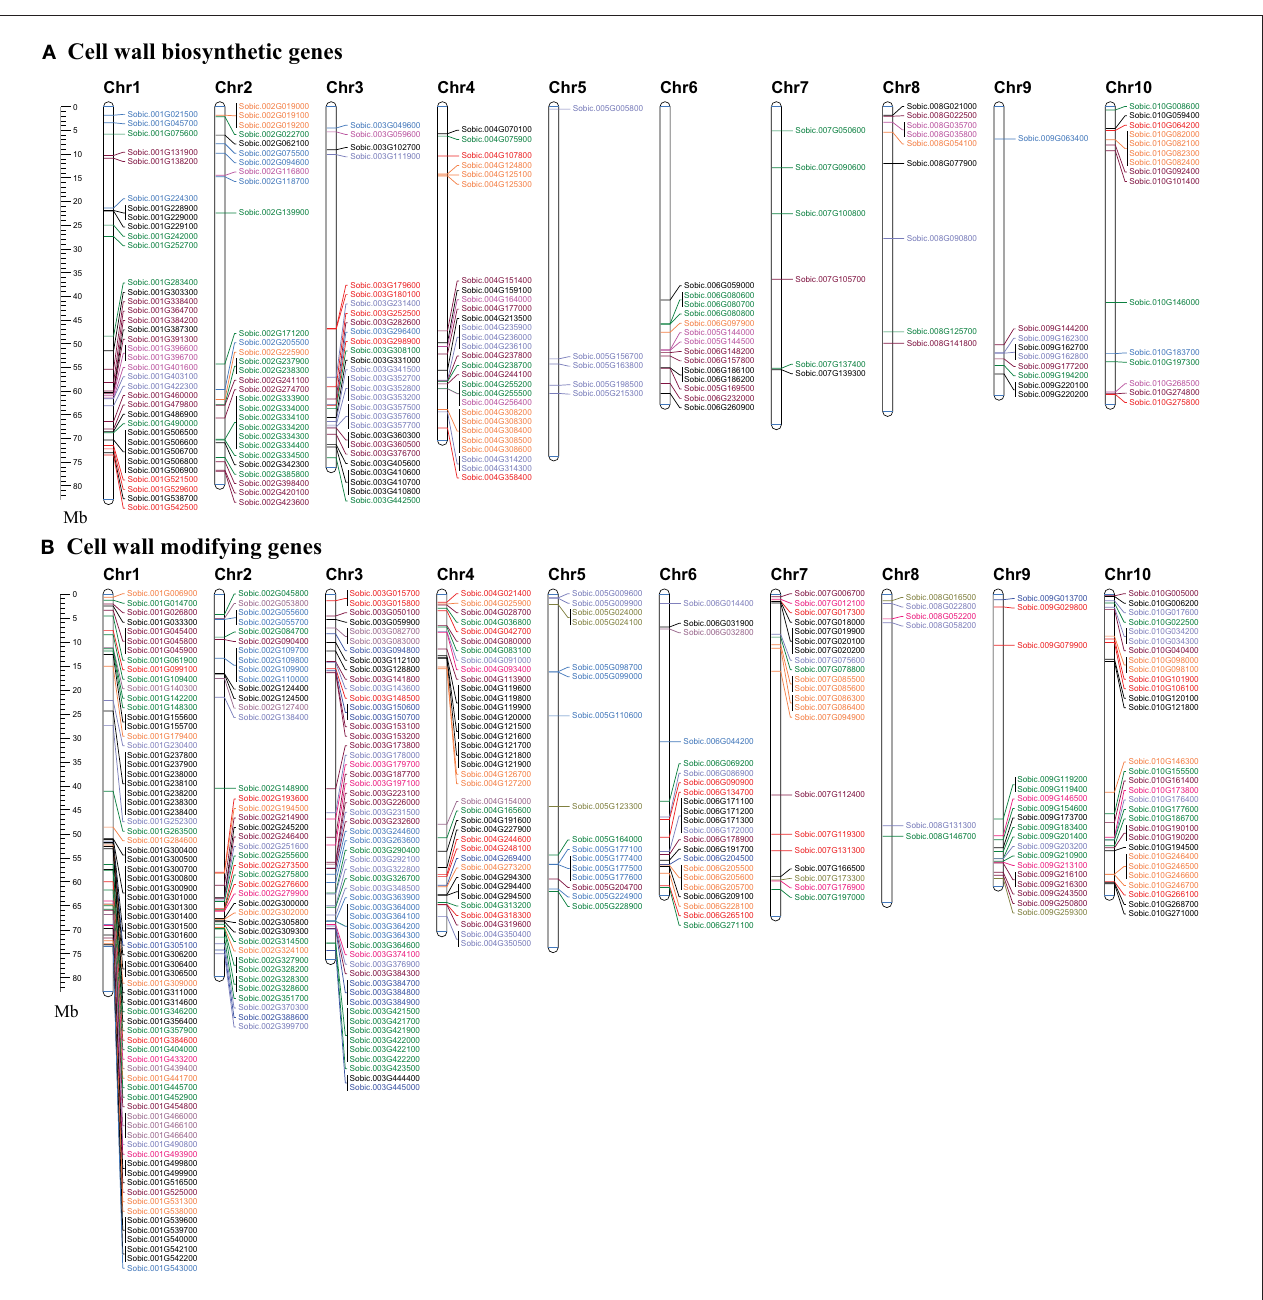
FIGURE 4 | Map showing the chromosomal location of cell wall related genes in sorghum. (A) Cell wall biosynthetic genes. (B) Cell wall modifying genes. Genes with name in same color represents same gene family. A scale in the left represents length of chromosome in megabases (Mb).